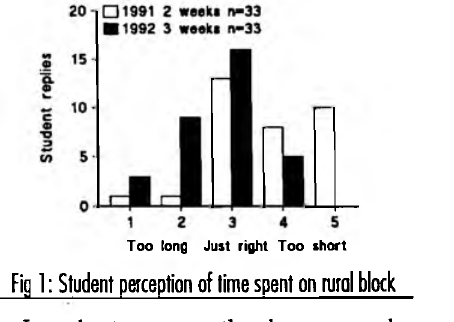
Fig 1: Student perception of lime spent on rural block In order to prepare the class more ade­ quately for their rural block in fourth year, concepts such as Primary Health Care